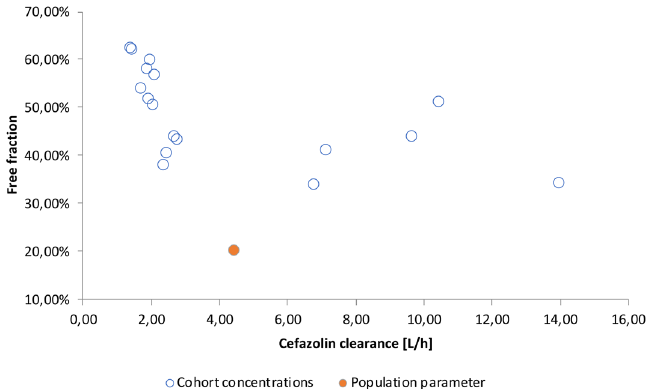
Figure 3. Cefazolin clearance and free fraction. This figure demonstrates the clearance in L/h (y-axis) and free fraction in % (x-axis) of cefazolin in comparison to population parameters. It shows the great variability of cefazolin clearance in our patients and that all measurements show greater unbound fraction than expected regarding the professional information of cefazolin.